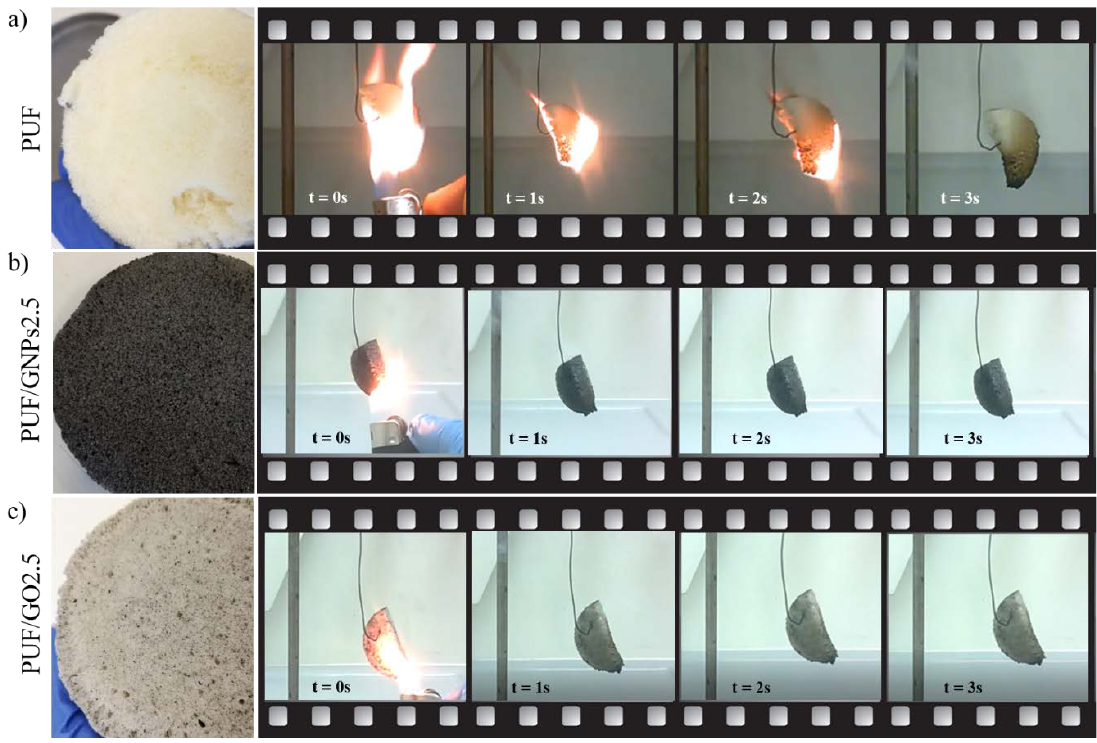
/ GNPs2.5, and ( c ) PUF /